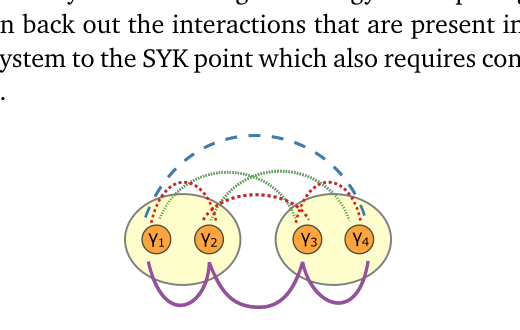
- γ (circles). All possible 1 4